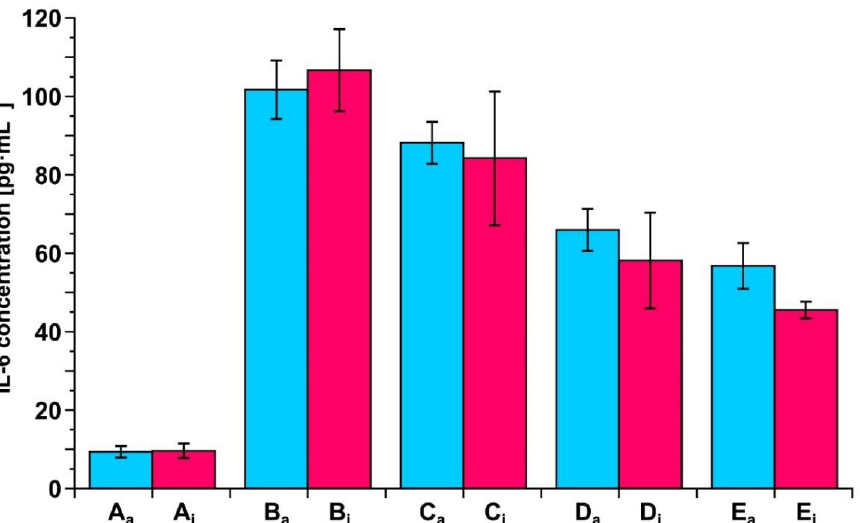
Figure 6. Changes in IL-6 concentration in the blood plasma of a patient before and after resection of ovarian tumor, as determined by the biosensor with the antibody as the receptor (blue) or the biosensor with the inhibitor as the receptor (red). A: control, B: before resection, C: 6 h, D: 24 h and E: 5 days after resection.